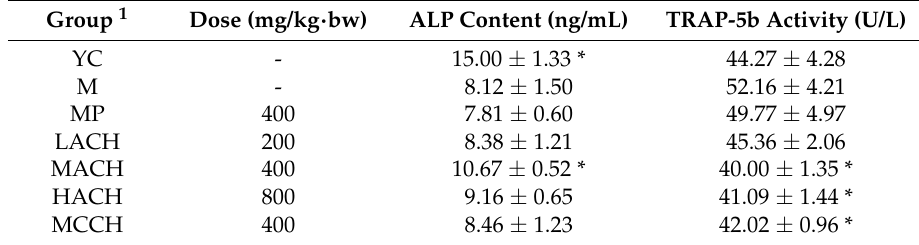
Table 4. Effects of collagen hydrolysates on bone serum biomarkers of mice.